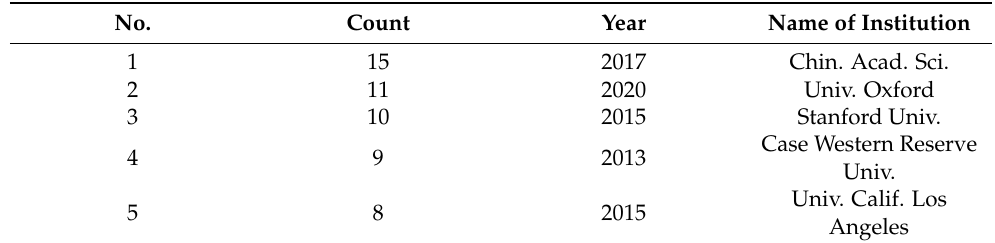
Table 4. Top 5 most productive institutions studying epidemic control based on big data research, extracted through CS analysis.